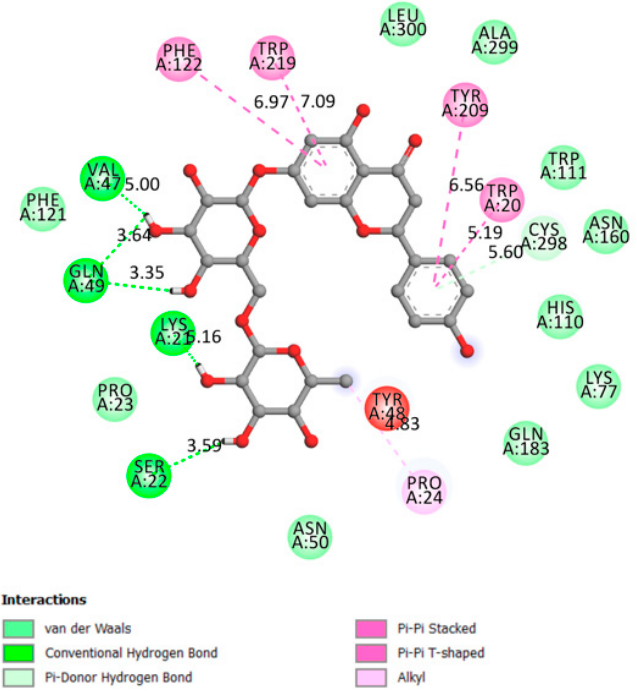
Figure 7. Two-dimensional scheme of the narirutin interactions with AldR.